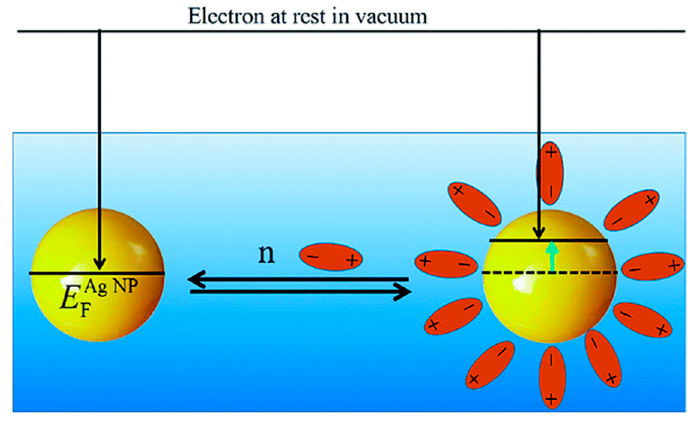
Figure 3. The Fermi level shift of metal nanoparticles Reproduced from ref. [39] with permission of The Royal Society of Chemistry.